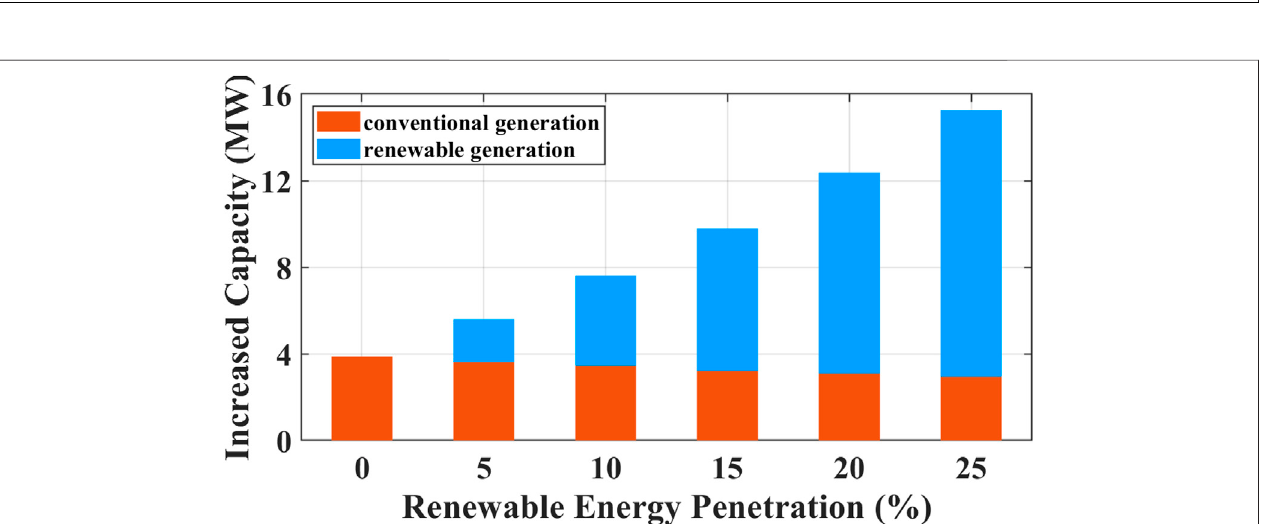
FIGURE 9 | Reliability results of generation capacity growth at different renewable energy penetrations in Case 3.